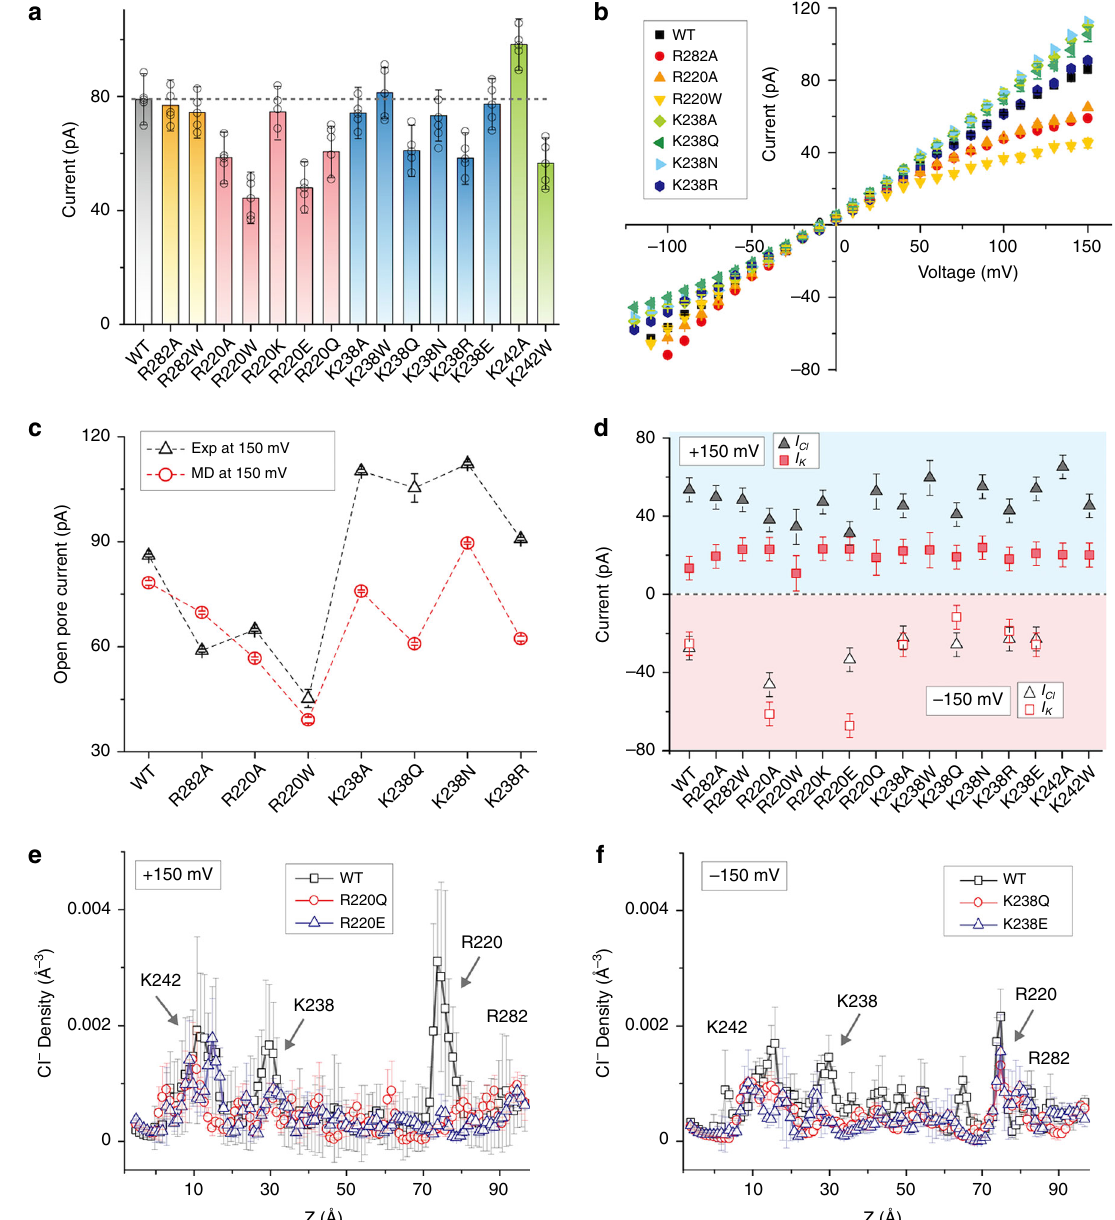
Fig. 2 Open pore current and ion selectivity of aerolysin mutants. a Simulated open pore current at + 150 mV in wt and engineered aerolysin pores. b Current – voltage relationships in aerolysin wt and mutants nanopores, where each point represents the mean value ± st. dev. of at least fi ve independent experiments. c Comparison of open pore current at + 150 mV calculated by MD simulations (red circles) with that obtained by single-channel experiments (black triangles). d The calculation of I Cl (black) and I K (red) in various engineered nanopores at 1.0 M solution of KCl electrolyte. At positive voltage, I Cl and I K are represented with solid triangles and squares, respectively, while shown with the open triangles and squares under negative voltages. e The averaged density of Cl − in wt (black squares), R220Q (red circles), and R220E (blue triangles) at + 150 mV along the z axis of the pore, as de fi ned by the local radii pro fi le shown in Supplementary Fig. 8 during 200 ns MD simulation. f The density of Cl − in wt (black squares), K238Q (red circles), and K238E (blue triangles) at − 150